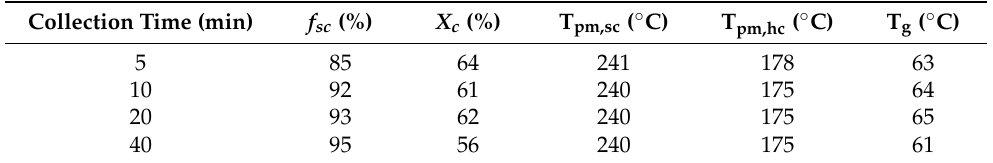
Table 3. The DSC results on the thermal properties and crystallinity of stereocomplex PLA at various collection